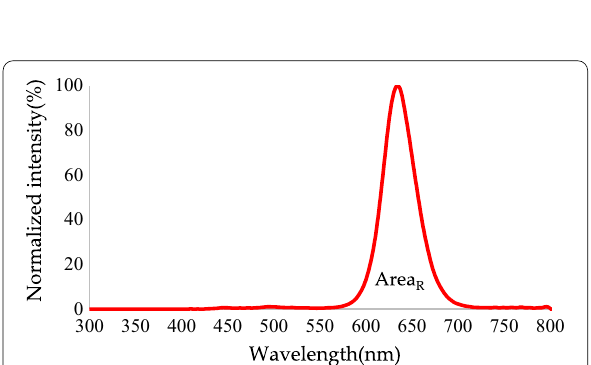
Fig. 10 Conversion of normalized blue light to a green spectrum by QDs after addition of RCPEF